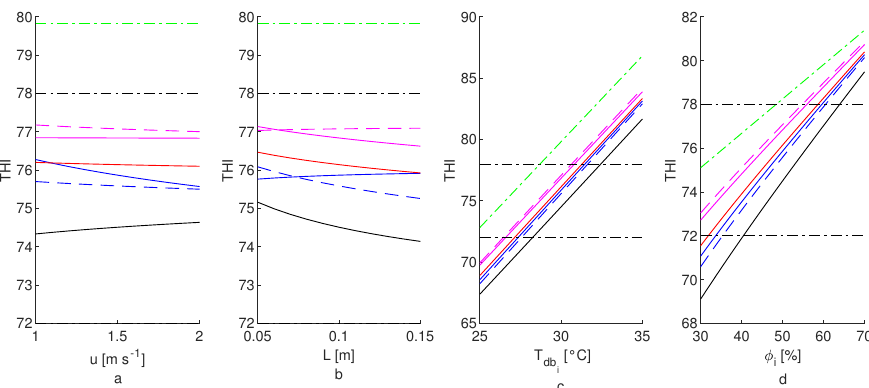
Figure 6. Comparison of the air outlet Temperature–Humidity Index (THI) of each pad material analysed. ( a ) As function of inlet air velocity ( u ). ( b ) As a function of pad thickness ( L ). ( c ) As a function of dry-bulb temperature of inlet air ( T db ). ( d ) As a function of relative humidity of inlet air i ( φ i ). For each plot, the other parameters remained constant: u = 1.5 m s − 1 , L = 0.1 m, T db = 30 ◦ C i and φ i = 60%. CL : solid black line; CS 1 : blue solid line; CS 2 : blue dashed line; BC : red solid line; PS 1 : magenta solid line; PS 2 : magenta dashed line; inlet air THI: green dash-dot line; middle thermal comfort THI zone for cattle: black dash-dot